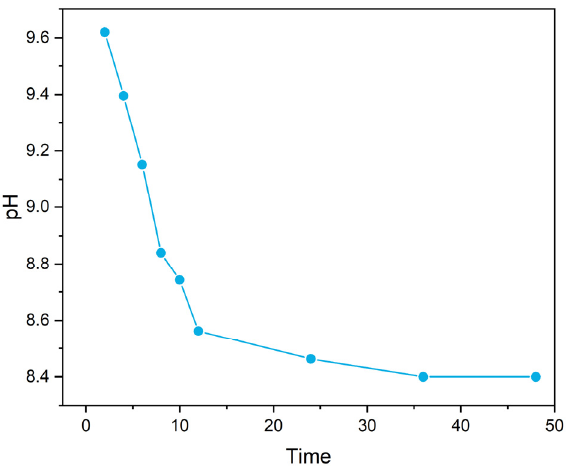
Figure 2. pH changes on time scale after continuous aeration.